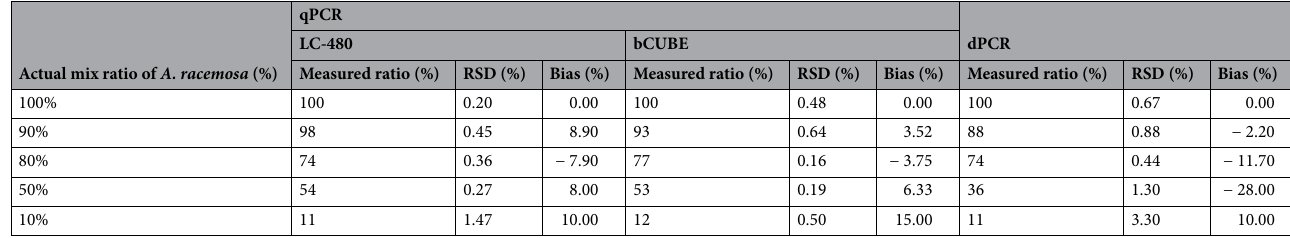
Table 2. Limit of quantification for engineered sample mixtures of A. racemosa using qPCR and